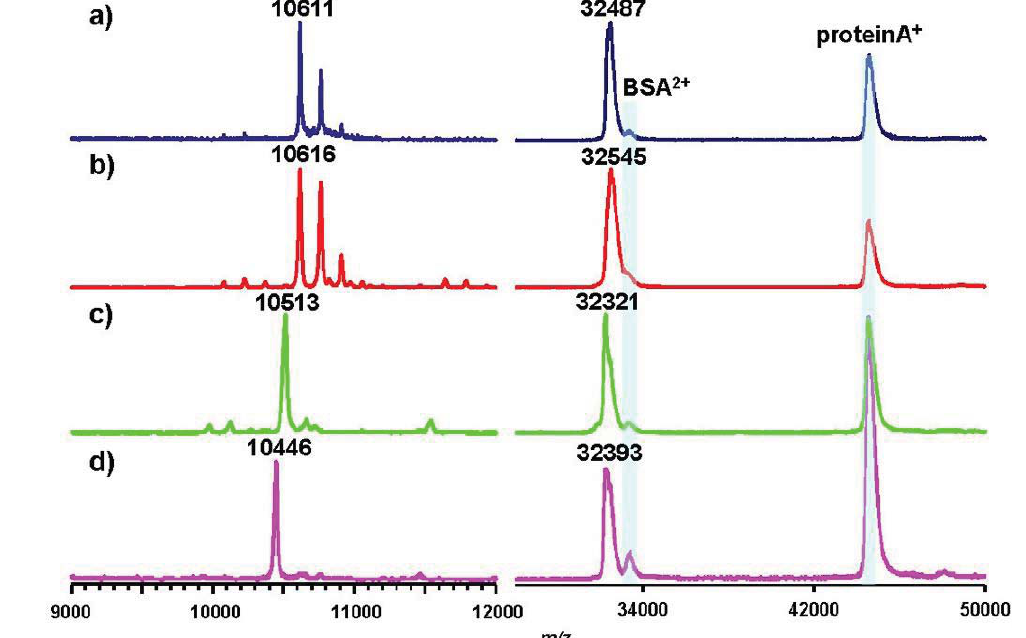
Figure 6. Comparison of MALDI-TOF mass spectra among pathovars in P. syringae . Mass spectra on the left side are of trypsin-digested flagellin polypeptide (N136-R210) of pv. tabaci 6605 ( a ), pv. phaseolicola 1448A ( b ), pv. tomato DC3000 ( c ), and pv. syringae B728a ( d ). Those on the right side are of intact flagellins. Blue peaks are of the calibration standard mixture.